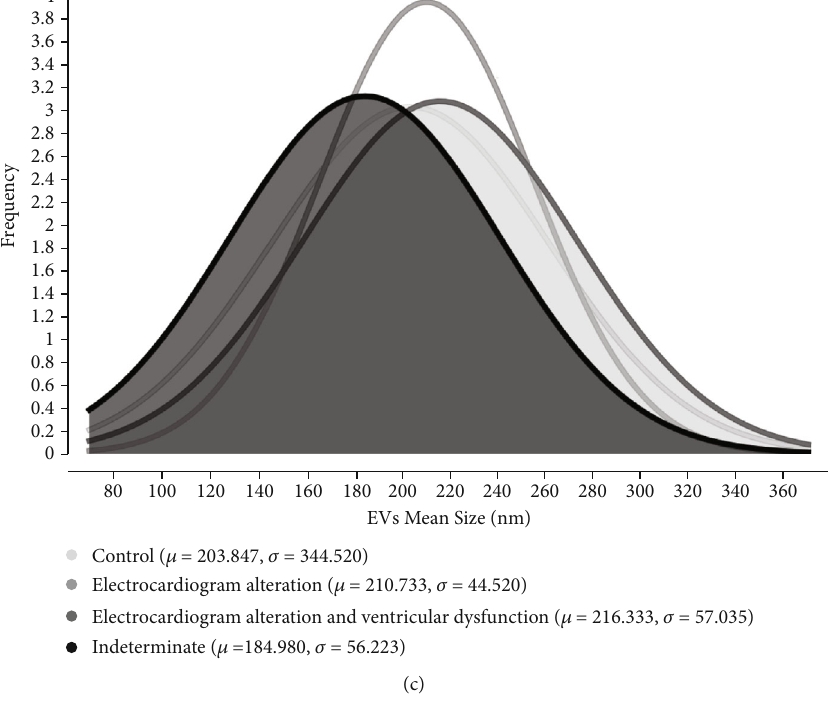
Figure 4: Comparison of circulating EV pro fi les in CCD patients in relation to CTRL. (a) Concentration ð particles/mL Þ × size (nm) pro fi le. (b) Frequency of EV concentration among di ff erent degrees of cardiac burden. (c) Frequency of EV size among di ff erent stages of cardiac burden.